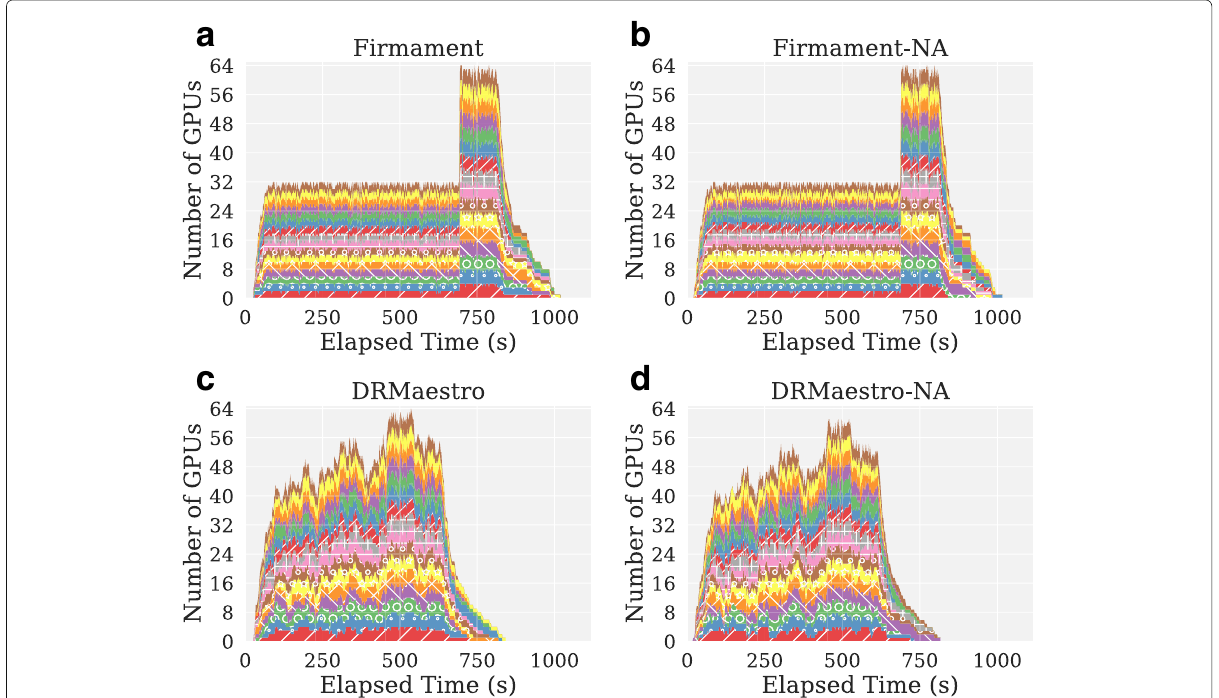
Fig. 7 Simulation results of orchestration with DRMaestro . Orchestration performed with DRMaestro with the implemented prototype in a cluster with 16 machines and 512